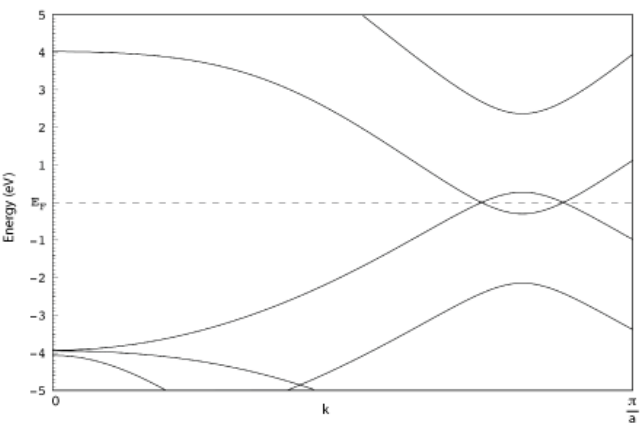
Figure 2. Band structure of the spin unpolarized state of the 2-ZGNR employed as metallic electrodes in the present